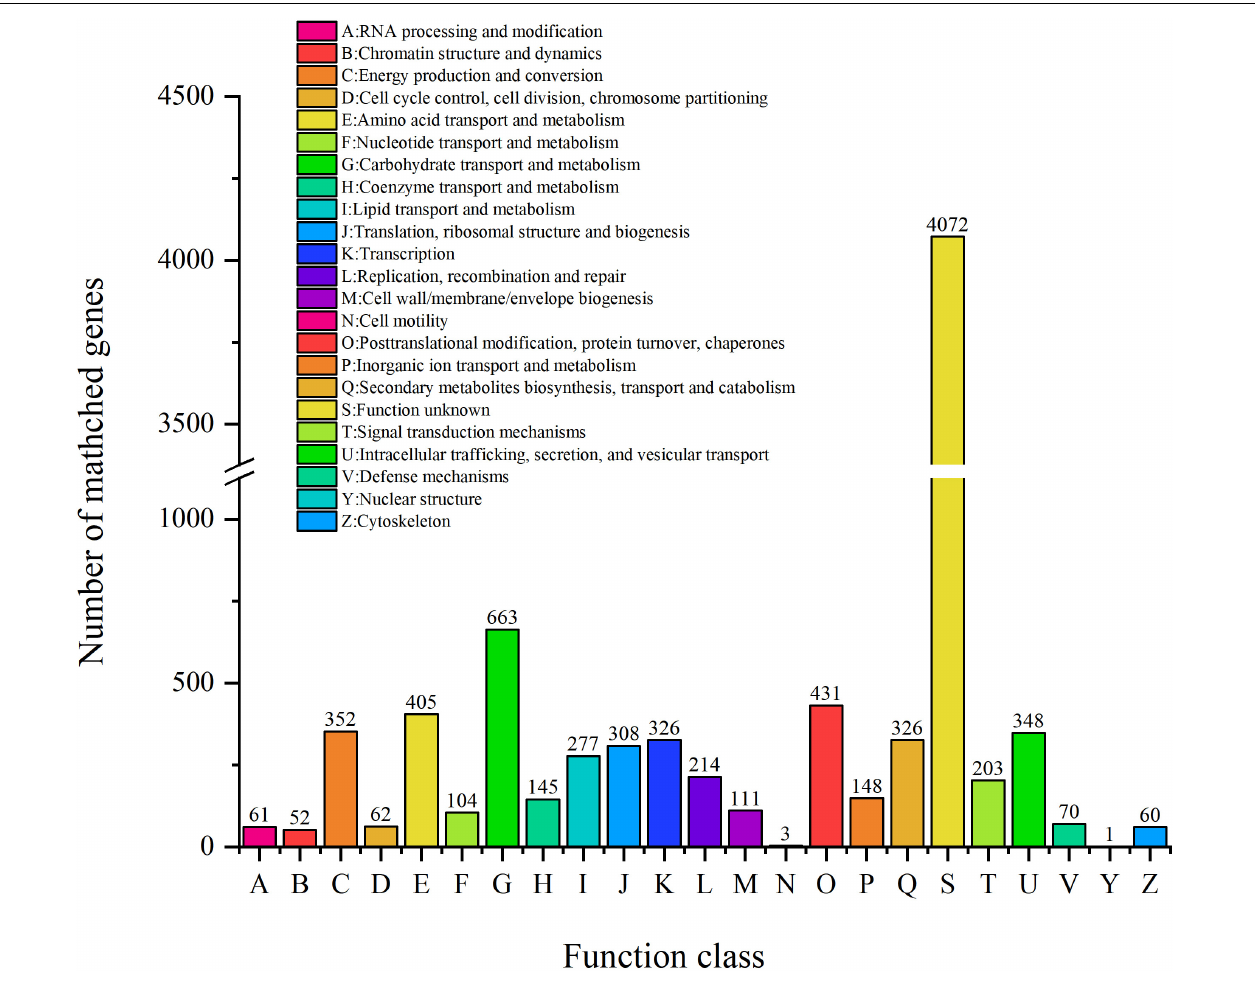
FIGURE 3 | The COG function classification of ZC-1005